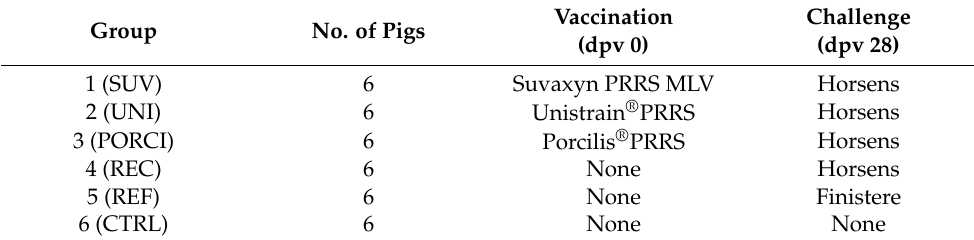
Table 1. Experimental design and groups. The pigs in groups 1–3 were vaccinated with either Suvaxyn PRRS MLV (SUV), Unistrain PRRS (UNI) or Porcilis PRRS (PORCI), according to the SPC of each vaccine. The pigs in groups 4–6 were left unvaccinated. At dpv 28, all pigs in groups 1–4 were challenged with the recombinant “Horsens” strain (REC) and the pigs in group 5 were challenged with the “Finistere” strain (REF). Vaccination Challenge Group No. of Pigs (dpv 0) (dpv 28) 1 (SUV) 6 Suvaxyn PRRS MLV Horsens 2 (UNI) 6 Unistrain ® PRRS Horsens 3 (PORCI) 6 Porcilis ® PRRS Horsens 4 (REC) 6 None Horsens 5 (REF) 6 None Finistere 6 (CTRL) 6 None